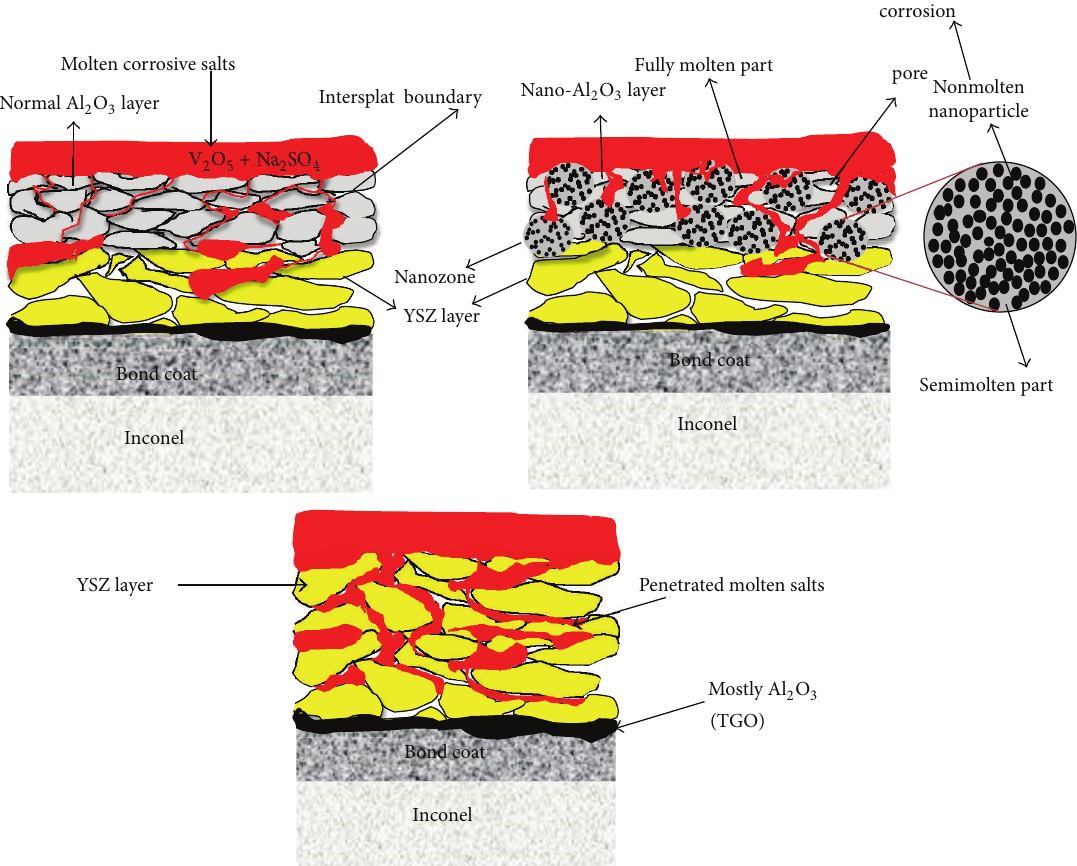
Figure 14: Schematic illustration of corrosive molten salts infiltration into the YSZ layer of different thermal barrier coating systems during hot corrosion process at elevated temperatures.